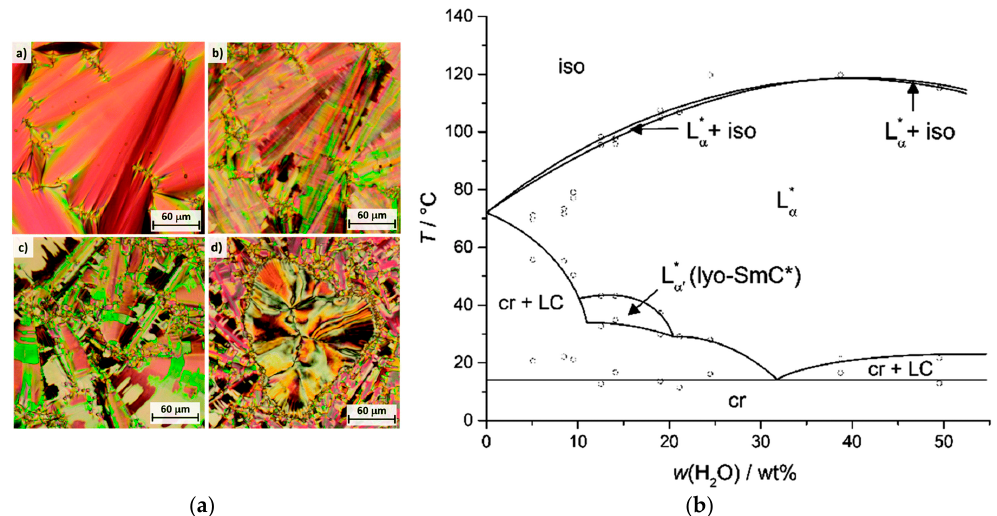
Figure 16. Mixtures of the amphiphile 5 with 19 wt% water show characteristic textures, as is known from thermotropic systems while cooling: ( a-a ) fan texture of the L α * phase, ( a-b ) broken fan texture of the lyo-SmC* phase, ( a-c ) well defined tilt domains of the lyo-SmC* phase at lower temperatures and ( a-d ) Schlieren texture of the lyo-SmC* phase surrounded by the broken fan texture. ( b ) Phase diagram of 5 with water. (Reprinted by permission from the Royal Society of Chemistry: [37].)